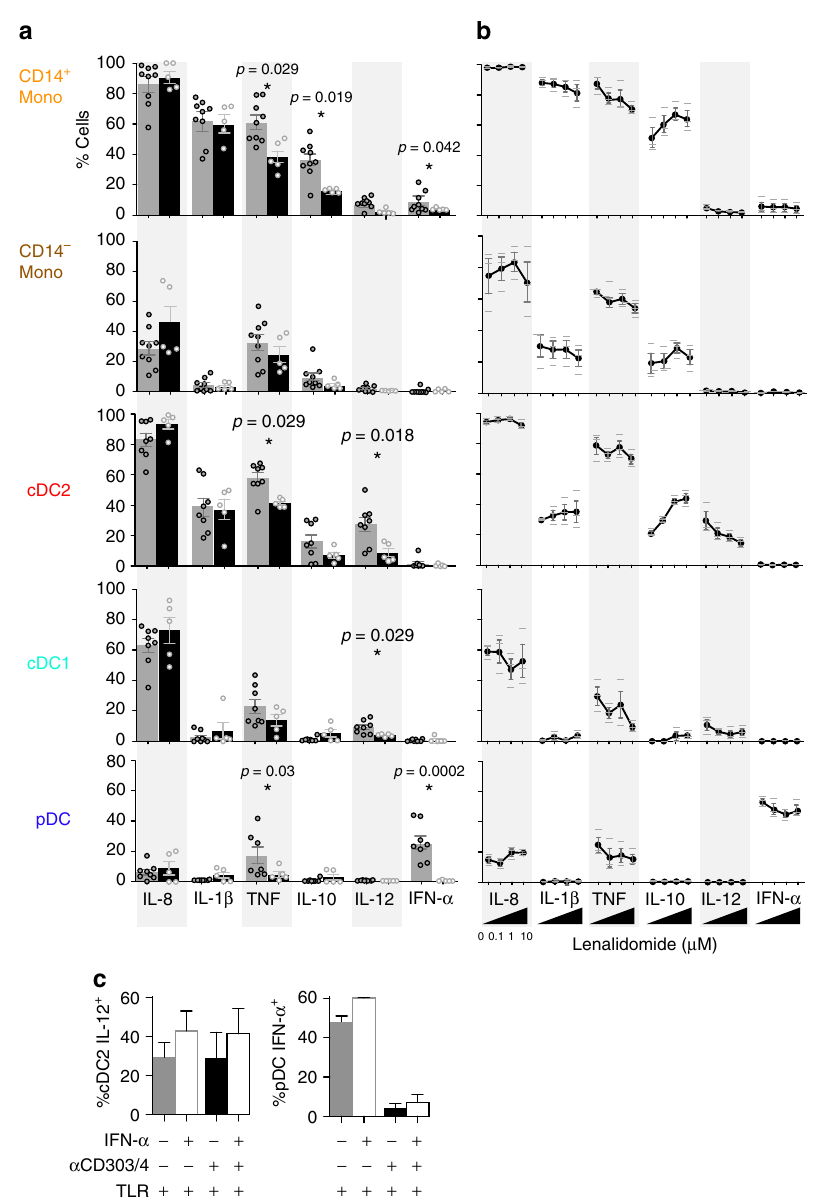
Fig. 4 Reduced production of TNF, IL-12 and IFN- α in IKZF1 de fi ciency. a Intracellular fl ow cytometric analysis of cytokine production (% positive cells) in PB CD14 + monocytes (mono), CD14 − monocytes and dendritic cell (DC) subsets (cDC2, cDC1, pDC) from n = 5 individuals carrying IKZF1 mutation (black bars) or n = 8 healthy donors (grey bars) following 14 h of stimulation of PBMCs with a cocktail of TLR agonists (CpG, poly(I:C), CL075, LPS). Histograms represent mean and bars represent s.e.m. Dots represent individuals. The p -values derived from Mann – Whitney U -test of IKZF1 mutation versus healthy donors. b Analysis repeated on healthy donor PBMCs in the presence of increasing concentrations of lenalidomide (0, 0.1, 1 or 10 μ M). Black dots represent mean, bars represent s.e.m. and lines represent individual data points from n = 3 donors in each condition. c IL-12 or IFN- α production from cDC2 or pDC, respectively, from healthy donor PBMCs stimulated with TLR cocktail (TLR) and without (solid bars) or with (un fi lled bars) the addition of exogenous IFN- α and without (grey) or with (black) anti-CD303 and anti-CD304